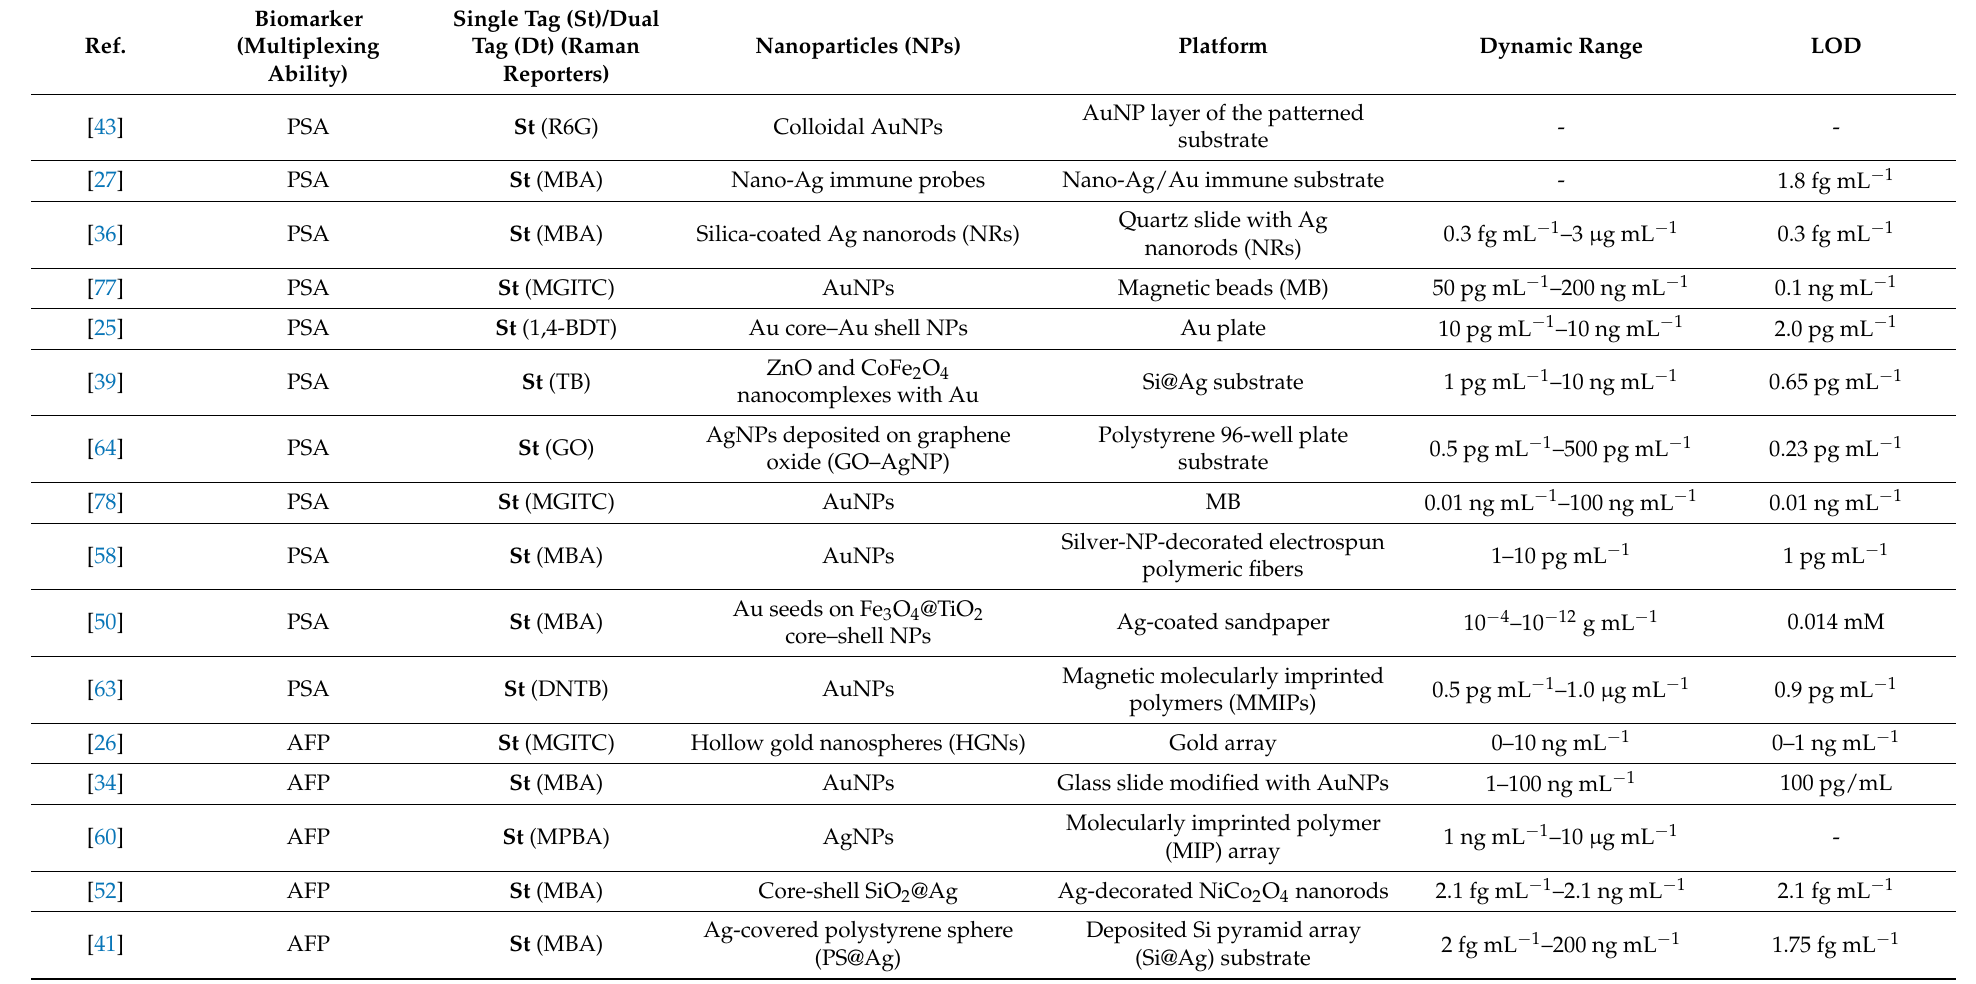
Table 1. Exemplary studies based on different SERS sandwich immunosensor designs for cancer detection resulting in different detection approaches.